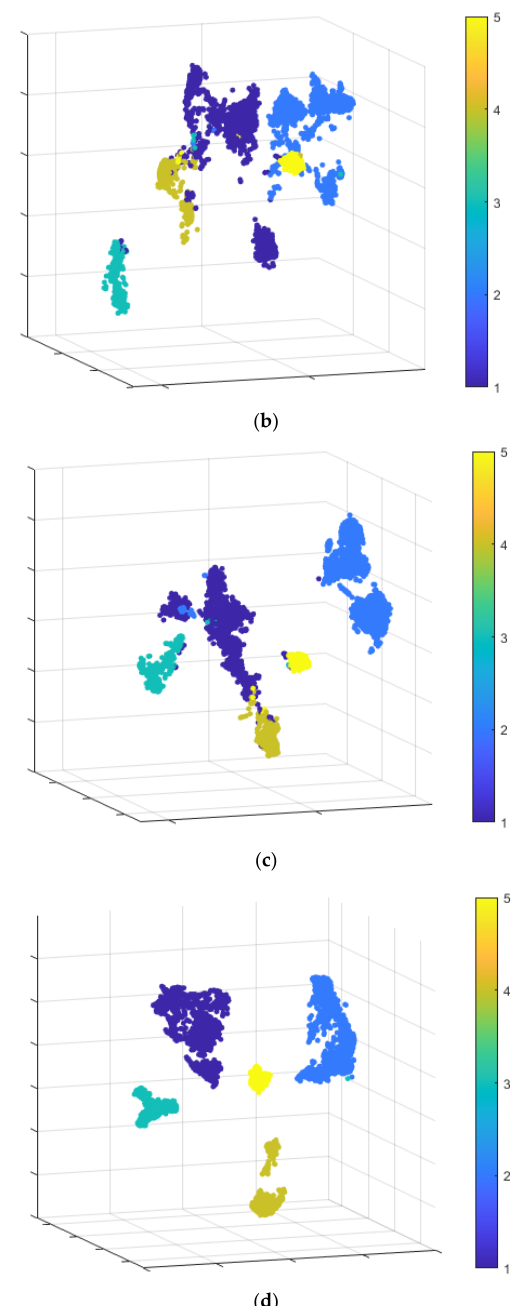
Figure 5. The representation map of the Barnes–Hut variation of t-SNE: ( a ) raw data; ( b ) 1DCNN- processed data; ( c ) 2DCNN-processed data; ( d ) FCNN-processed data.